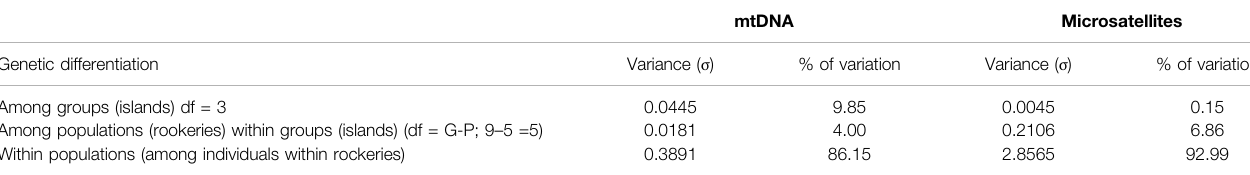
TABLE3| Analysisofmolecularvariance(AMOVA)usingthemtDNAcontrolregionandeightmicrosatellitelocifor Arctocephalusgalapagoensis .StatisticsformtDNA: F CT = 0.098, F SC =0.044,and F ST =0.138;Statisticsformicrosatellites F CT = − 0.011, F SC =0.037,and F ST =0.026.Allvaluessigni fi cantat p < 0.001;df=degrees offreedom (Note: F -statistic estimators intheAMOVA arerandomvariablesand cantakeeitherpositiveornegative values. Suchnegativeestimates shouldbeinterpretedaszerointhe AMOVA (Schneider et al., 2000)).